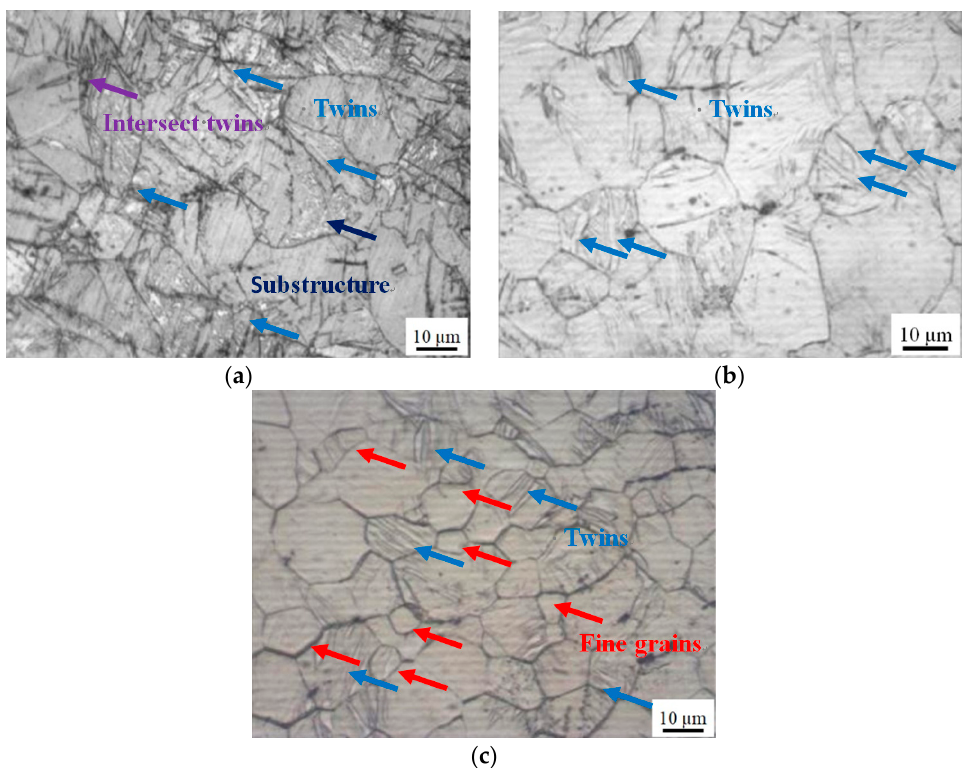
Figure 3. Microstructure in elevated temperature under 1000 s − 1 : ( a ) 20 °C, ( b ) 150 °C, ( c ) 250 °C. In all the temperature conditions, a large number of twins are present at 1000 s − 1 , which partly consist of double twins and intersect twins. Meanwhile, the substructures are observed at 150 °C, which are randomly dispersed in the large grains. By comparing Figure 3a,b, it can be obviously seen that the twins gradually thickened and more dense with the increased temperature. Additionally, the grains are gradually separated by the twins. This phenomenon is usually caused by twinning dislocation spread on adjacent planes [20]. In addition, the c ‐ axis, the normal direction of (cid:4668)0002(cid:4669) plan, is perpendicular to the loading direction, which is also a benefit for (cid:4668)101(cid:3364)2(cid:4669) tension twinning activation. Additionally, the twins’ boundaries generated in the same grains are usually parallel to each other [29]. In Figure 3c, a large number of refinement grains are present, with grains of 3–4 μ m radius size. On one hand, the twins completely disappeared as a result of detwinning occurring in some grains. On the other hand, the density and thickness of the twins are further increased. As fine grains induce slip deformation more easily, twinning is hardly activated. However, when the refinement grains are grown to be coarse grains by the elevated temperature, the formation of twinning is more easily activated [28]. Hence, the refinement grains may have been caused by dynamic recrystallized (DRX) as the temperature increased. Additionally, the twins in large grains may be present after the refinement grains. 4. Discussion 4.1. Effect of Temperature on Microstructure Evolution The inverse pole figure (IPF) maps, pole figure (PF), boundaries misorientation (BM) and twins’ volume fraction (TVF) of the wrought AZ31 ‐ TD alloy after impact are shown in Figure 4, which was obtained from the EBSD data collected. In Figure 4, the black line is the grain boundary. The red line and green lines are the (cid:4668)101(cid:3364)2(cid:4669) tension twin boundary and (cid:4668)101(cid:3364)1(cid:4669) contraction twin boundary, respectively, which is illustrated and corre ‐ sponds to the red line and green line in Figure 4h.